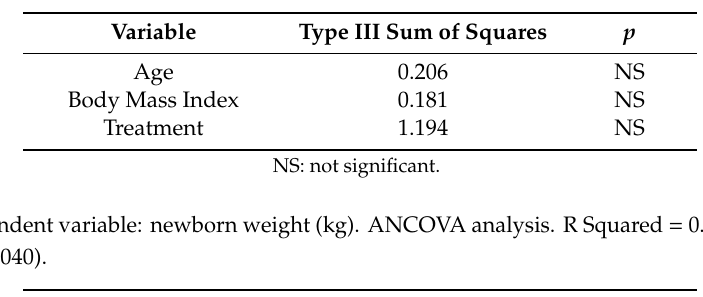
Table 6. Dependent variable: pregnancy time (weeks). ANCOVA analysis. R Squared = 0.019 (Adjusted R Squared = − 0.065).